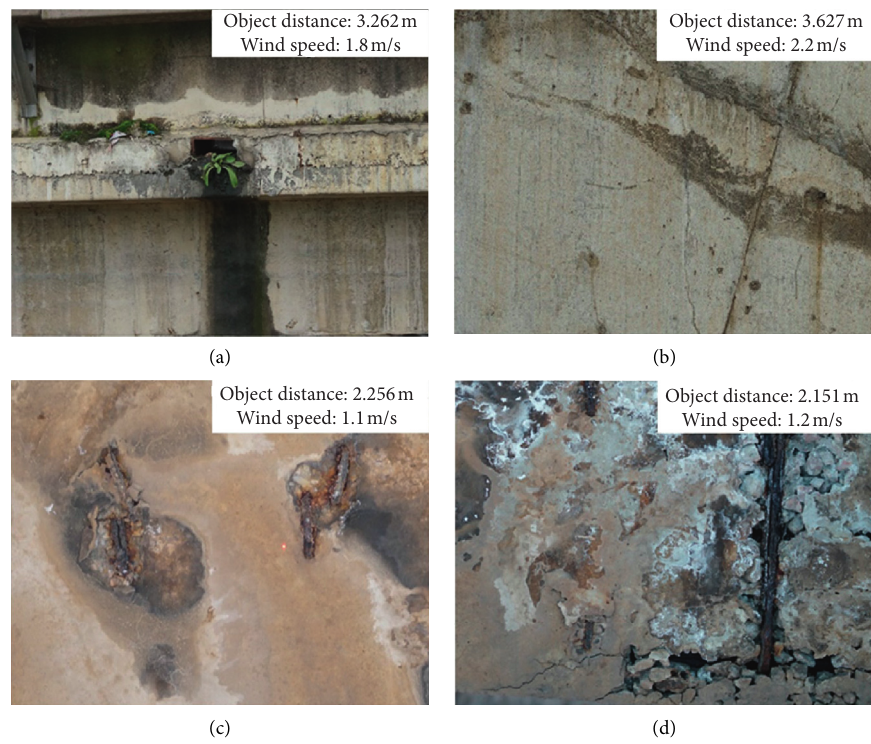
Figure 12: Bridge inspection images based on UAV, (a) water seepage, (b) crack, (c) reinforce bar, and (d) concrete spalling.